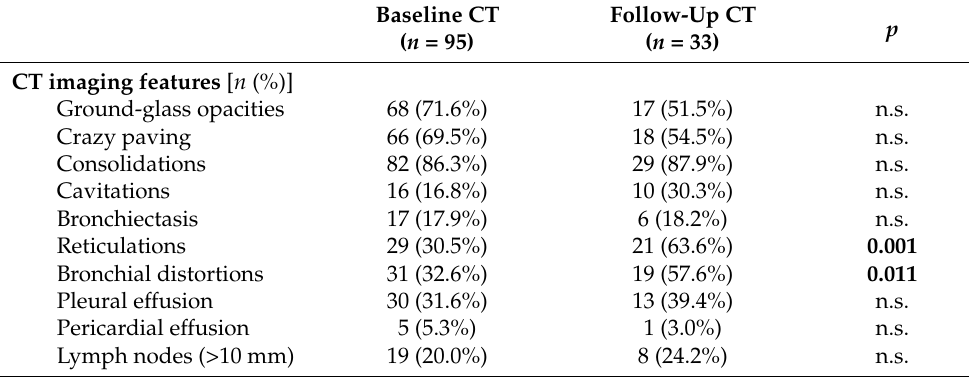
Table 4. Comparison of imaging findings of COVID-19-related ARDS at baseline and during follow-up